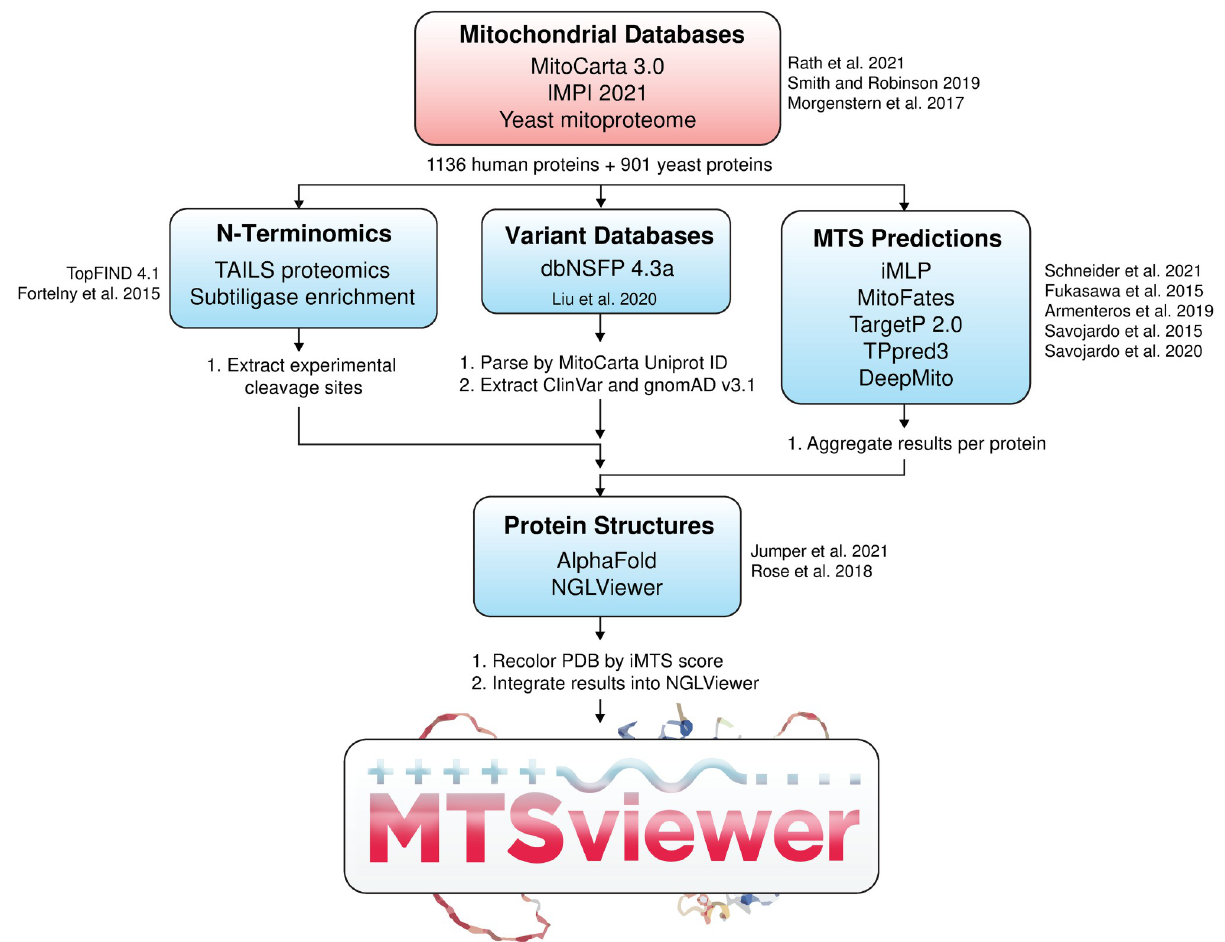
Fig 1. Workflow of MTSviewer. The database construction of MTSviewer, from initial mitochondrial databases to data integration and visualization.